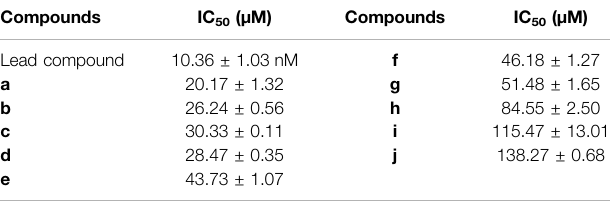
TABLE 3 | Inhibitory activity of compounds in vitro . Compounds